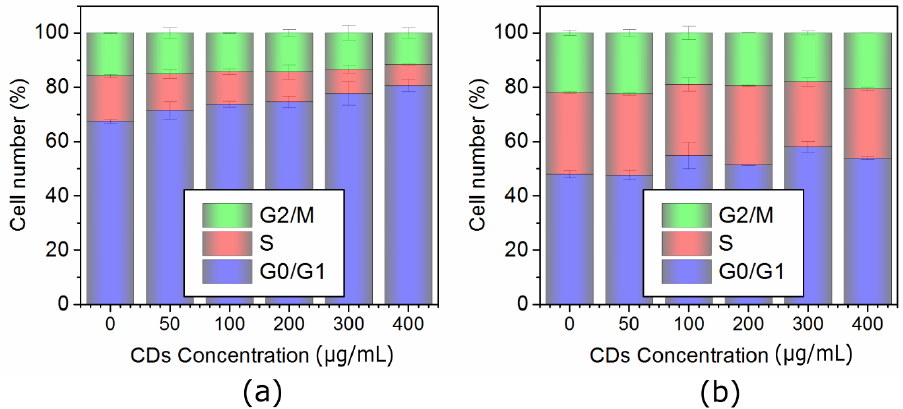
Figure 9. Cell cycle profile of cells labeled with QCDs: ( a ) Healthy mouse NIH/3T3 fibroblasts, ( b ) Healthy mouse L929 fibroblasts.